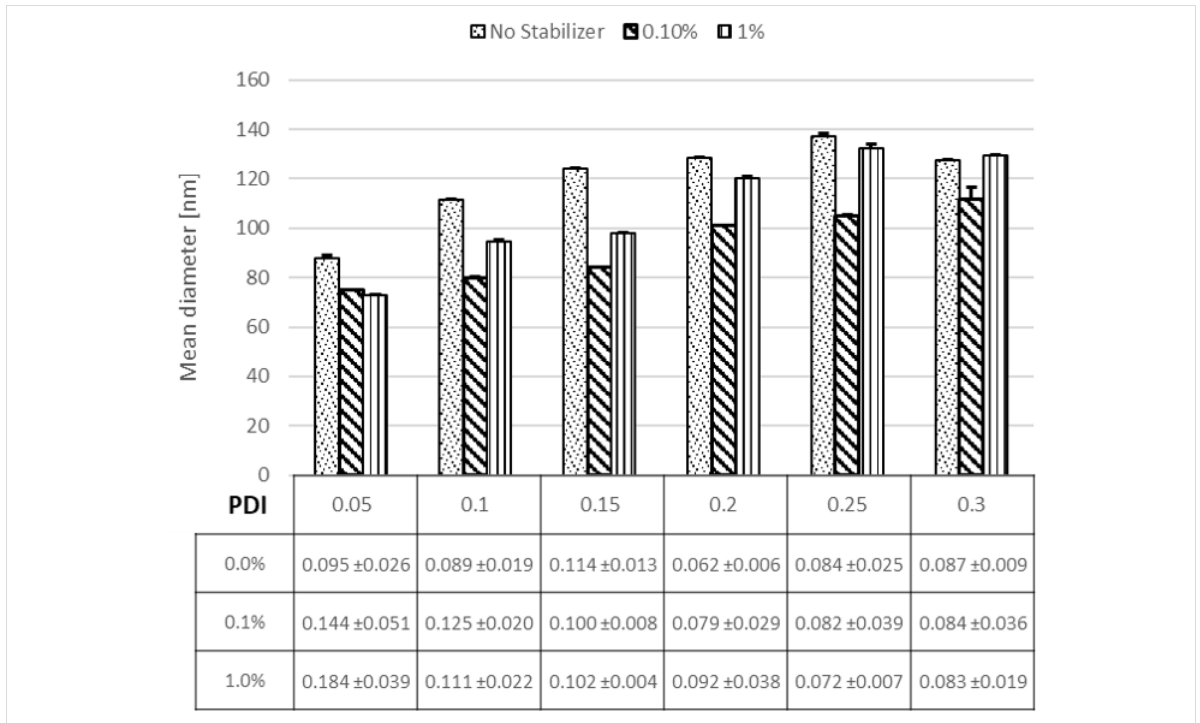
Figure 5: Effect of stabilizer concentration (0.1% and 1% of F68) on NP size and size distribution compared to NPs without stabilizer.